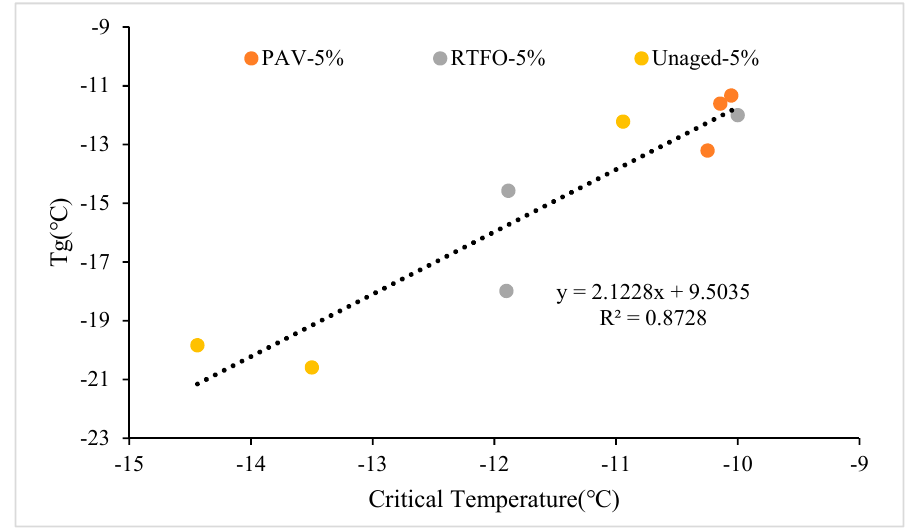
Figure 10. The relationship between critical temperature and T g for SBS modified binder at different aging states.